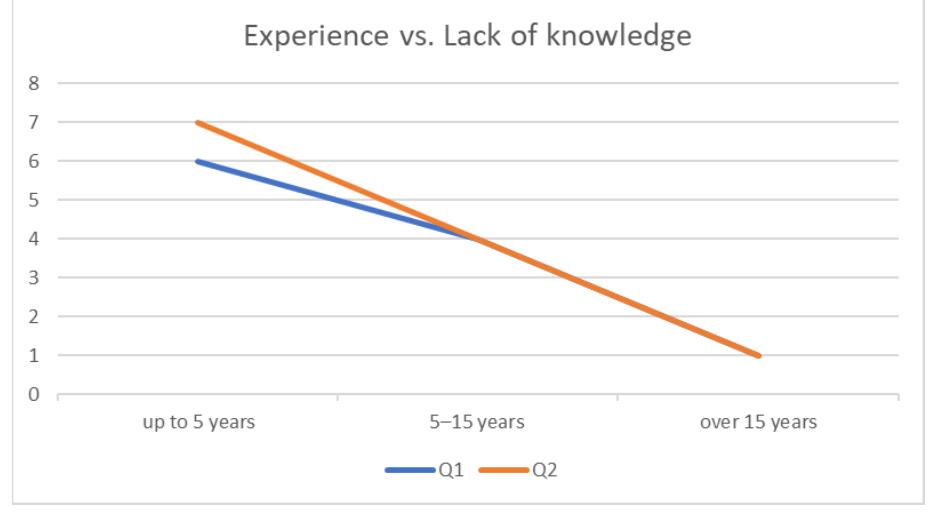
Figure 7. The trend line of a decrease in response uncertainty as experience increases.